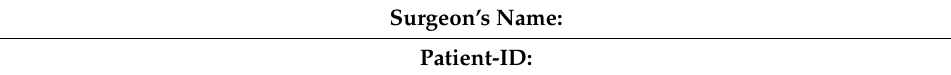
Table 1. Questionnaire regarding the anatomical structure detection as well as the recommended surgical strategy for patients with anterior skull base meningiomas, using conventional CT and MRI modalities (2D and screen 3D) or 3D-VR presentations.